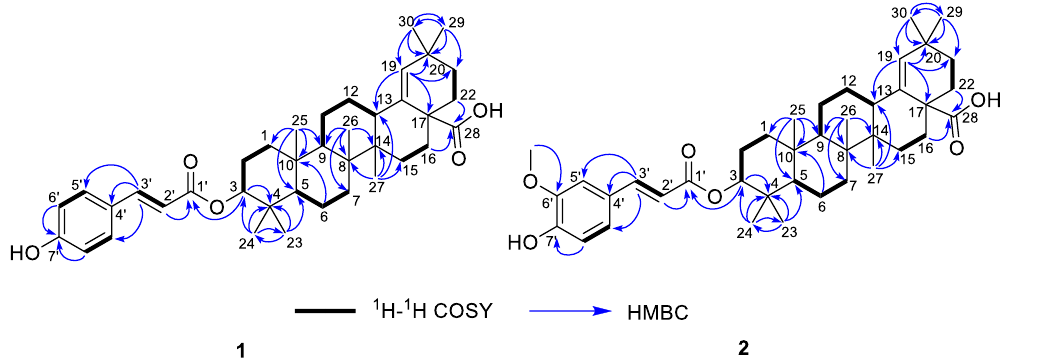
Figure 2. The 1 H − 1 H COSY and HMBC correlations of 1 and 2. Figure 2. The 1 H– 1 H COSY and HMBC correlations of 1 and 2 .